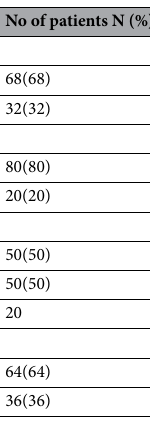
Table 2. No of cases observed in the study according to their clinical and pathological feature.